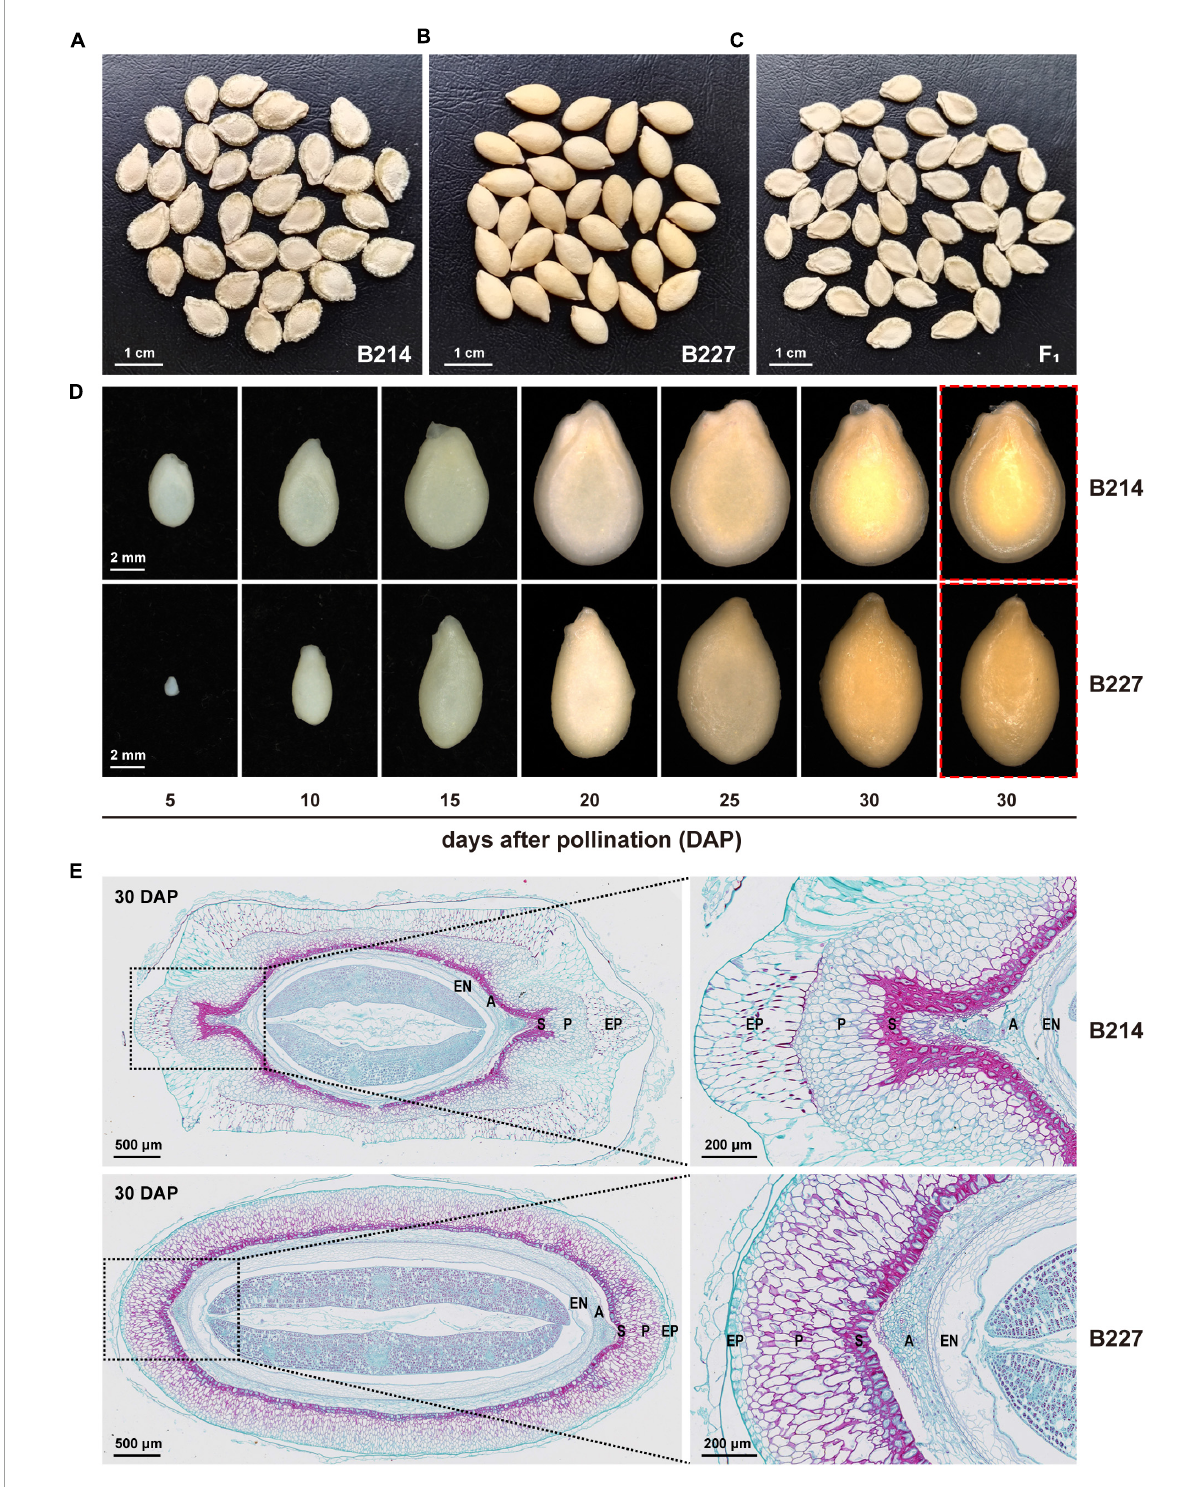
FIGURE1 Phenotypic differences between wax gourd inbred lines B214 and B227. Mature seeds of (A) B214, (B) B227, and (C) F 1 hybrid. (D) Seeds of B214 and B227 at different developmental stages. Red boxes indicate seeds with epidermal mucosa removed. (E) Transverse sections of the seeds of B214 and B227 at 30 days after pollination (DAP). EP, epidermis; P, parenchyma; S, sclerenchyma; A, aerenchyma; EN,